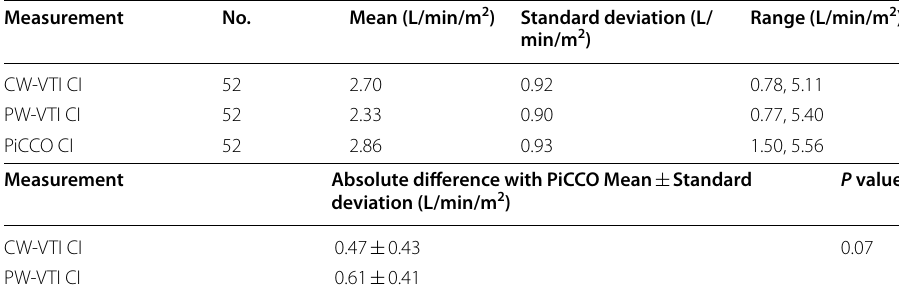
Table 2 Summary of cardiac index results including mean, standard deviation, range and absolute difference with PiCCO mean